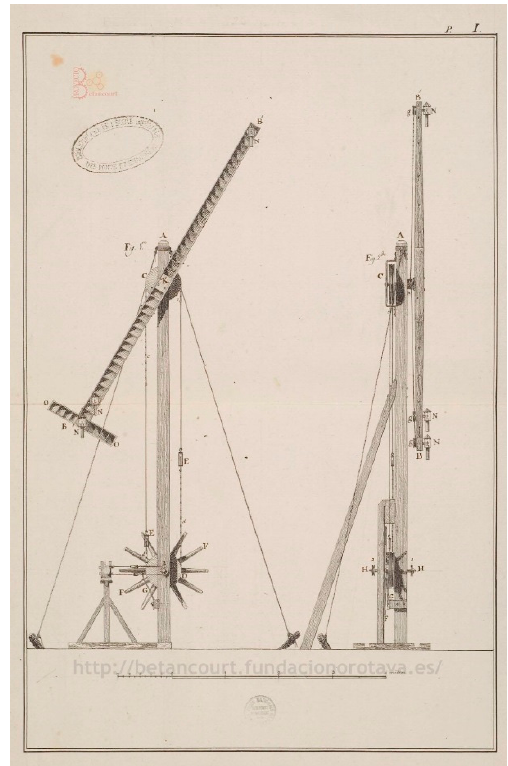
Figure 1. Elevation (left) and profile (right) views of the optical telegraph by Agustín de Betancourt and Abraham Louis Breguet [18] (Courtesy of Fundación Canaria Orotava de Historia de la Ciencia).